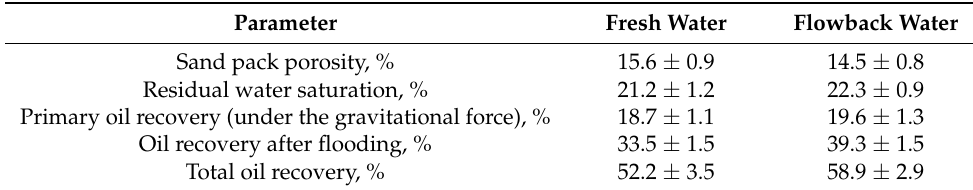
Table 4. Summary of flooding tests performed with fresh and flowback water.